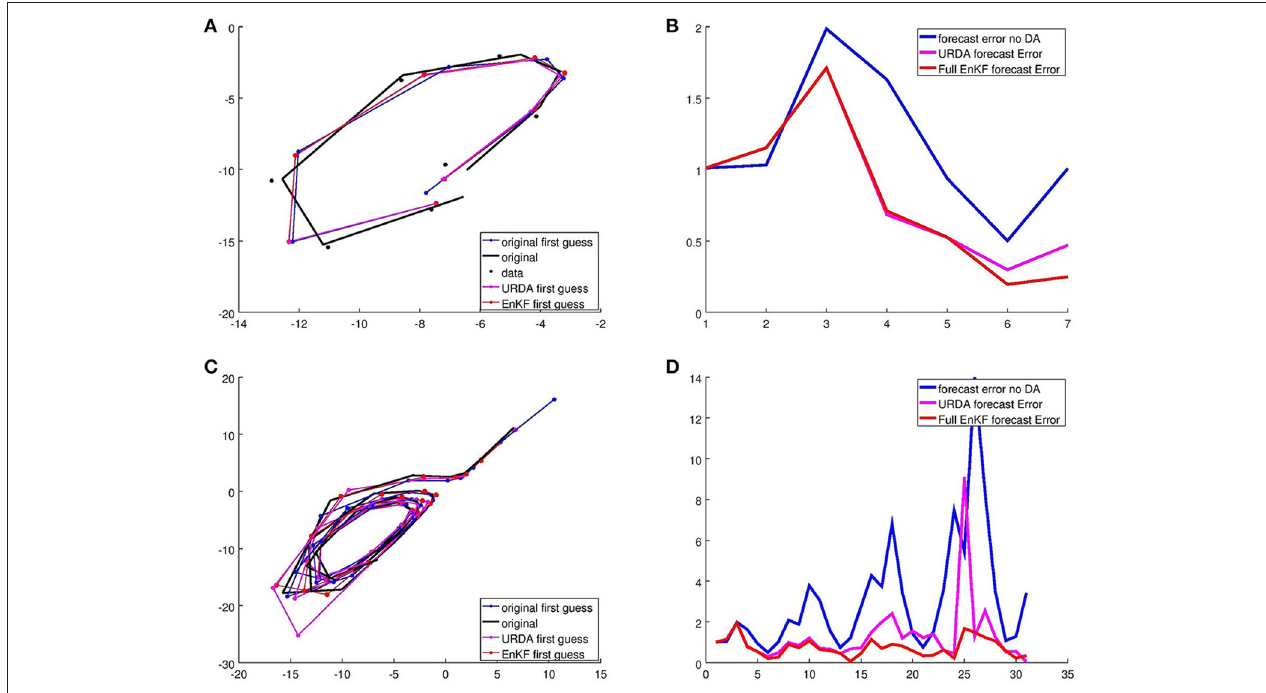
FIGURE 6 | We show the results of the ultra rapid data assimilation in comparison with the ensemble Kalman square root filter for the Lorenz 1963 model for N assimilation steps and the reduced data case with observation operator H 2 . In (A,C) , the black curve is the original, black dots are the observations. The mean of the analysis ensemble of the ultra rapid data assimilation URDA after k 8 assimilation steps is shown in pink, where we need to note that here the information of the = data is used to update the full curve at all points (i.e., the estimate of the past is updated as well. The red curve shows the analysis ensemble mean of the sequential ensemble Kalman square root filter. (B,D) show the sequential error curves of the analysis error for the two observed variables only, pink for URDA, red for the ensemble Kalman square root